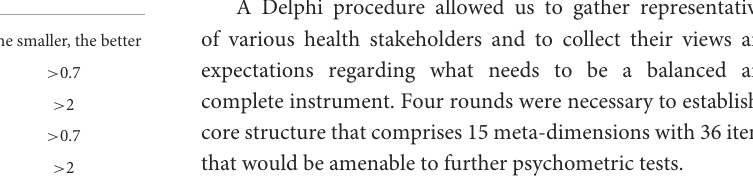
TABLE 8 Standard error of measurement, item/person separation index and item/person separation reliability. Psychometric